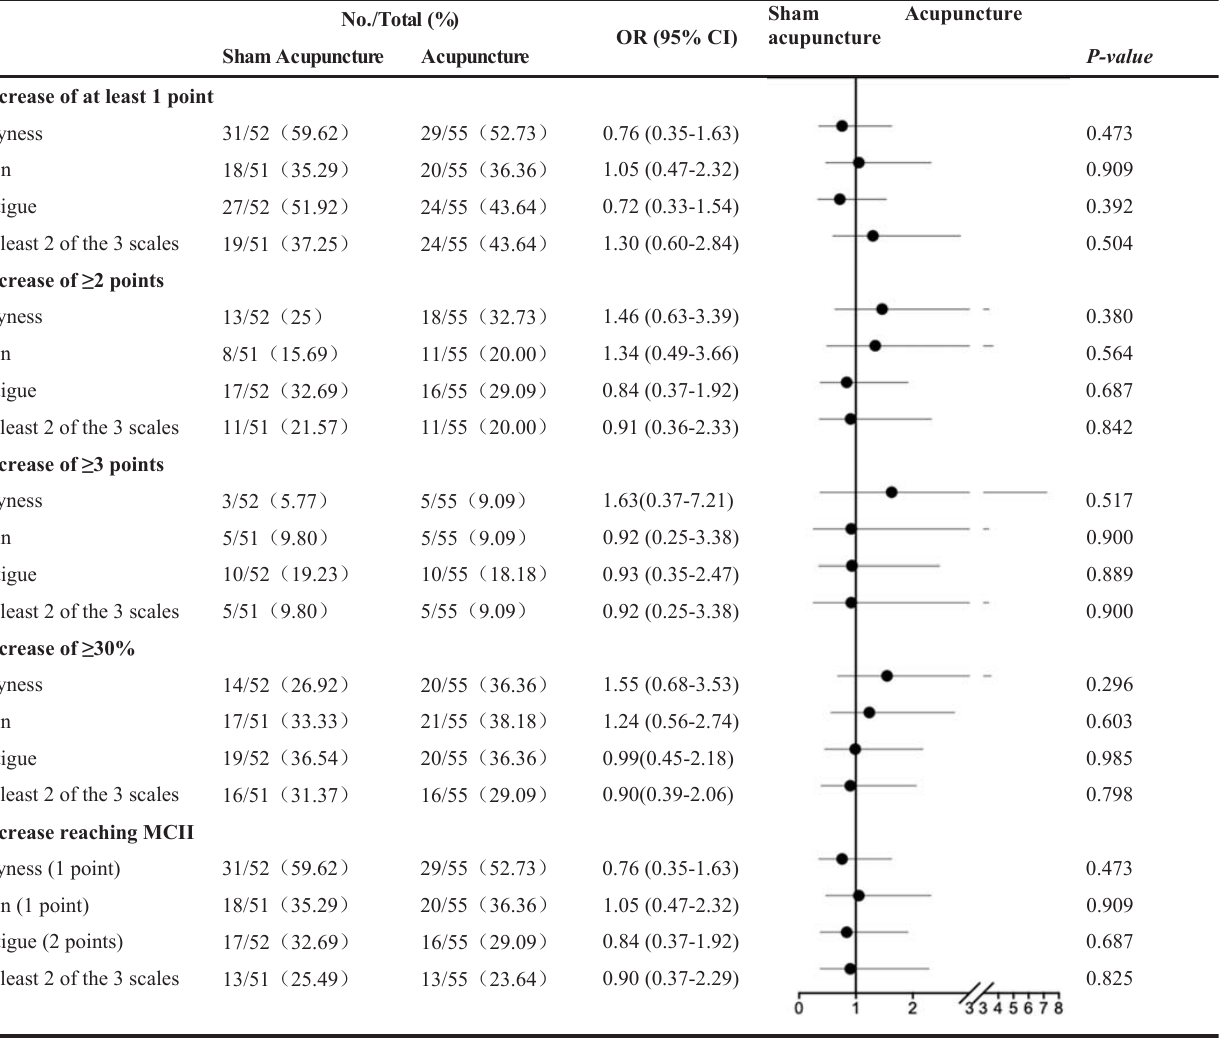
TABLE 5 | Sensitivity of evolution in NAS scores in dry, pain and weak in patients with pSS, between baseline and week 8. )%(latoT/.oN OR (95%